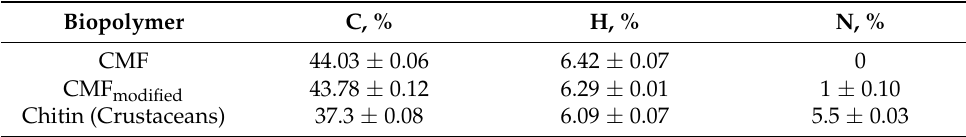
Table 1. Elemental analysis of CMF modified , pristine CMF, and